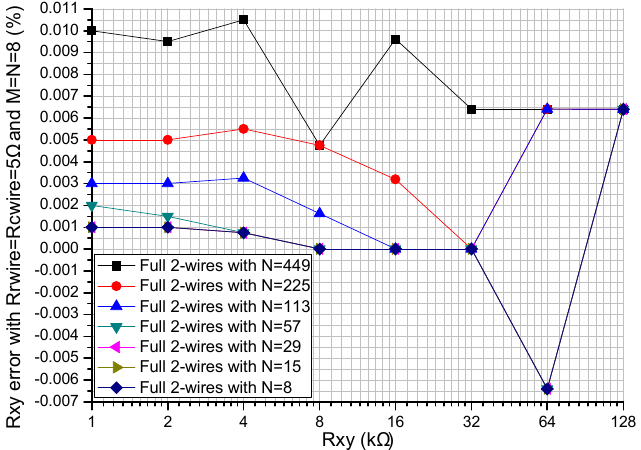
Figure 6. Effect of N on the R xy errors in the full two ‐ wire circuit where R rwire = R cwire = 5 Ω and M = N = 8.